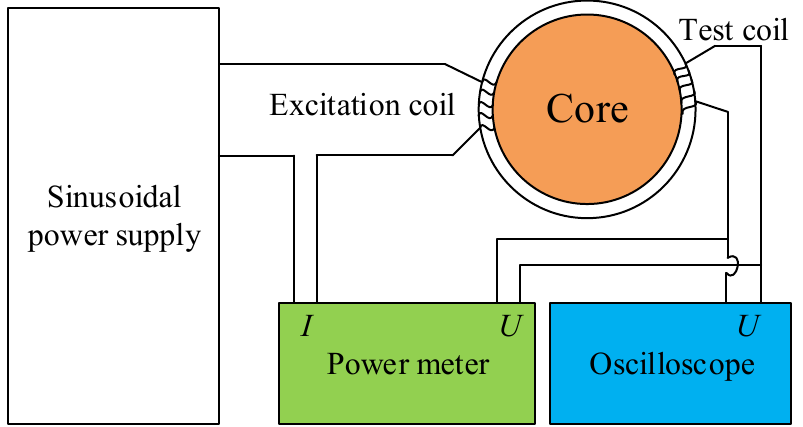
Figure 1. Schematic diagram of the experiment.